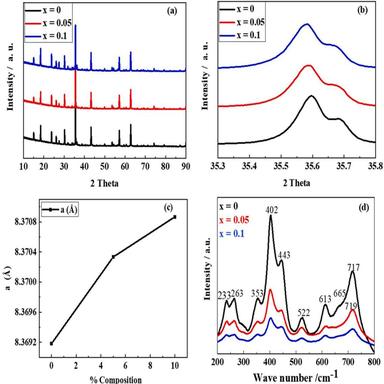
(a) XRD pattern (b) enlarged (311) diffraction peak, (c) Unit cell parameter a (Å) on the basis of Rietveld refinement and (d) Raman spectra of LZTNO.